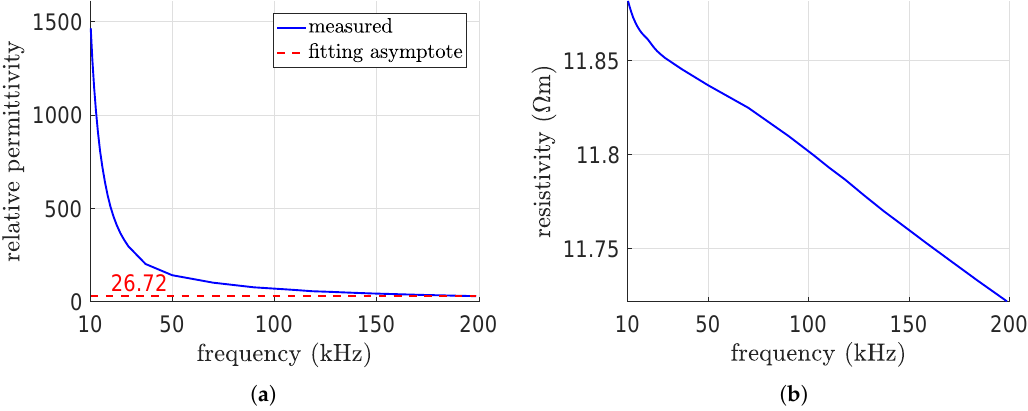
Figure 9. Measured concrete relative permittivity and resistivity versus frequency at 28 days after